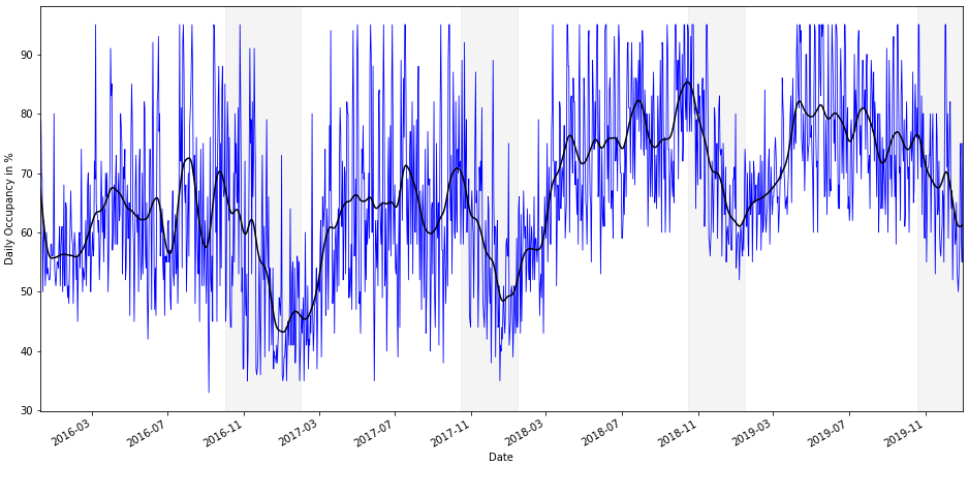
Figure 2. Hotel daily total